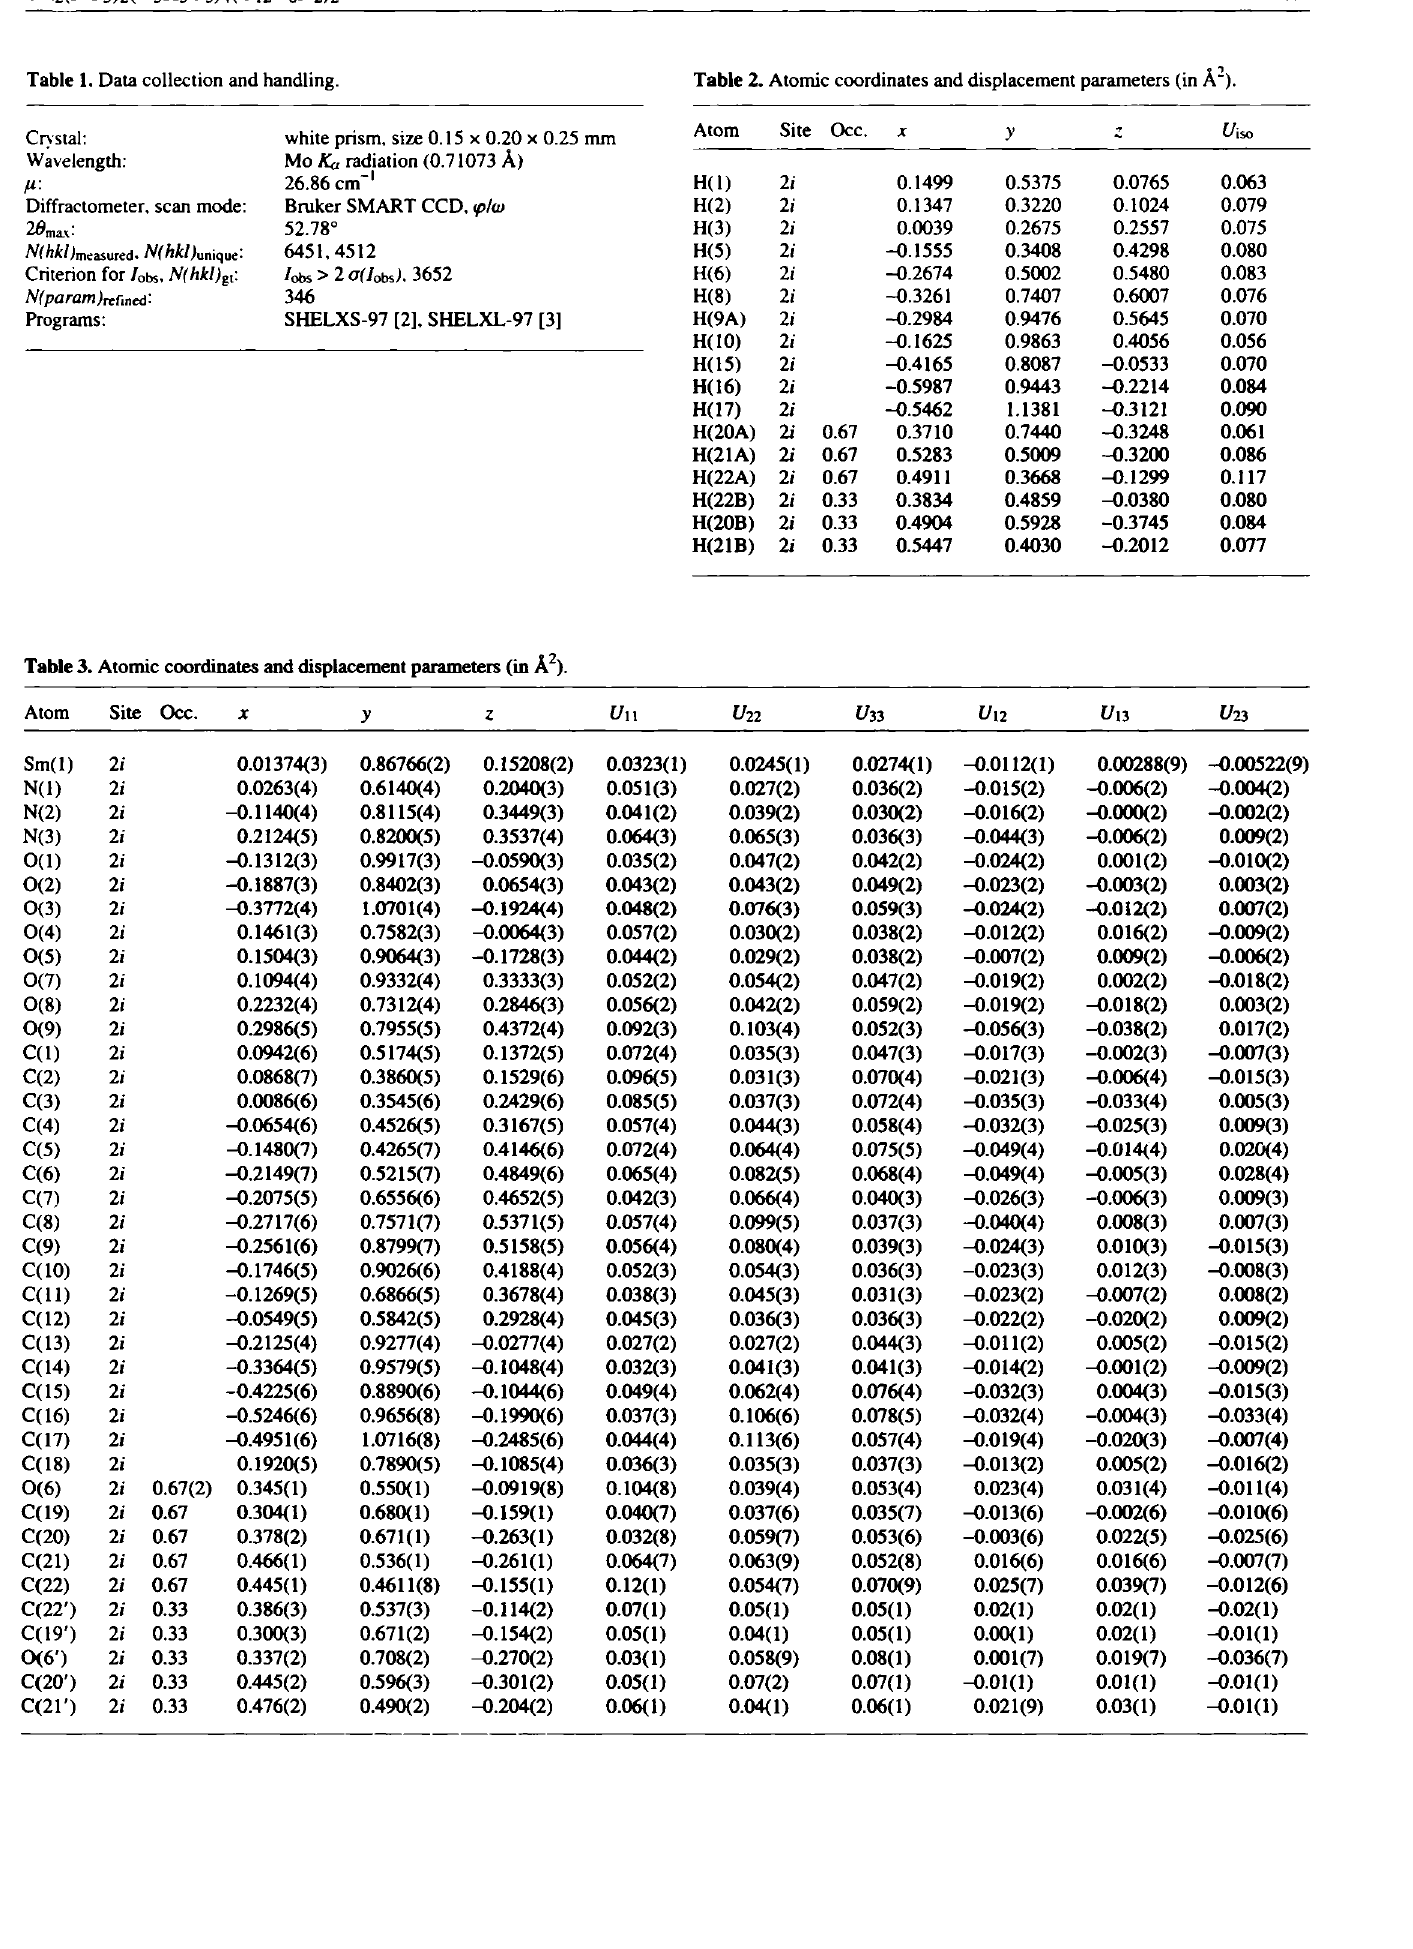
Table 3. Atomic coordinates and displacement parameters (in Â 2